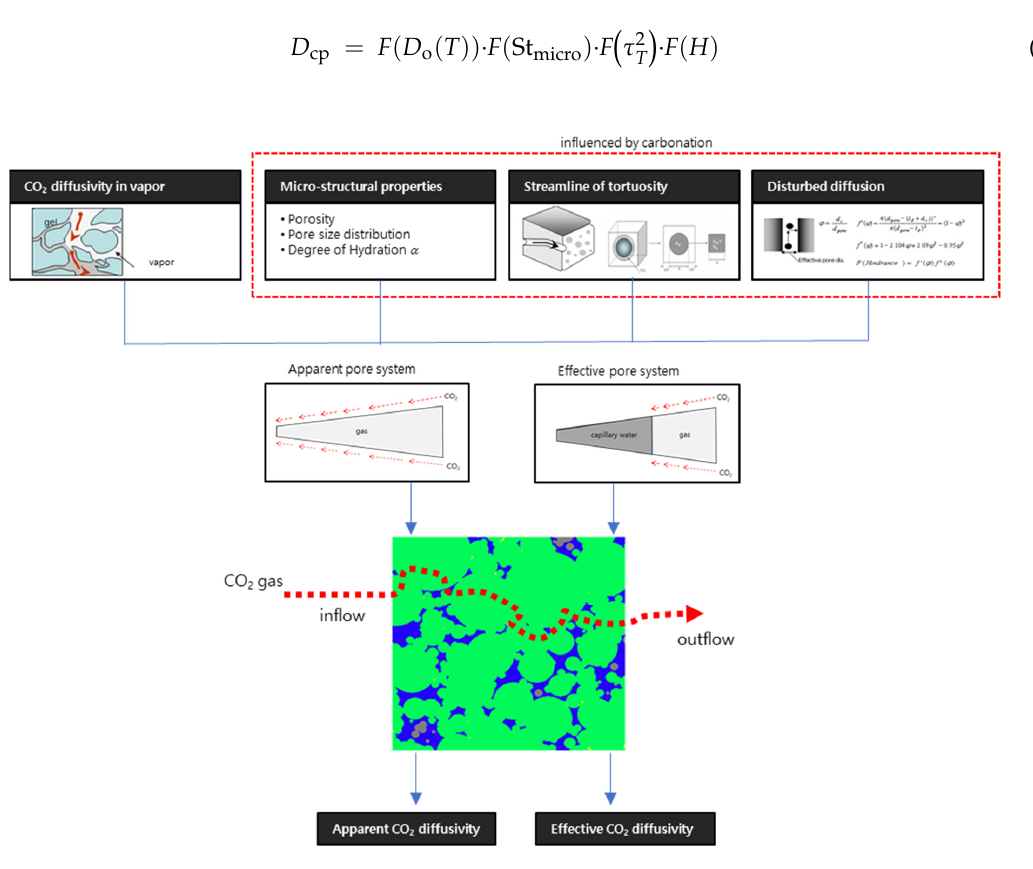
Figure 2. Model of CO 2 diffusivity with four multifunction (modified from [4]).